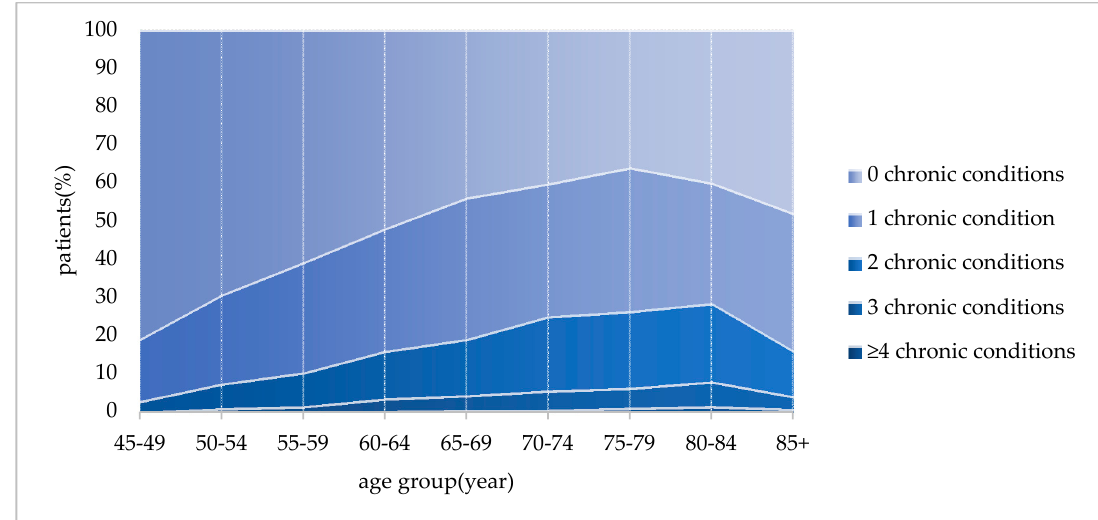
Figure 1. Prevalence of multimorbidity by different age groups.